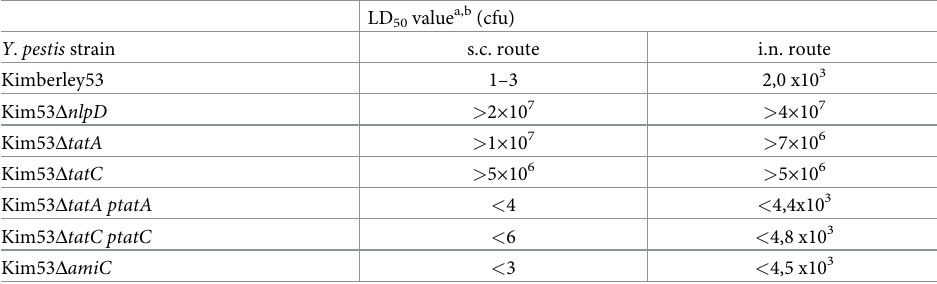
Table 3. Virulence of Y . pestis strains in mouse models of bubonic and pneumonic plague.